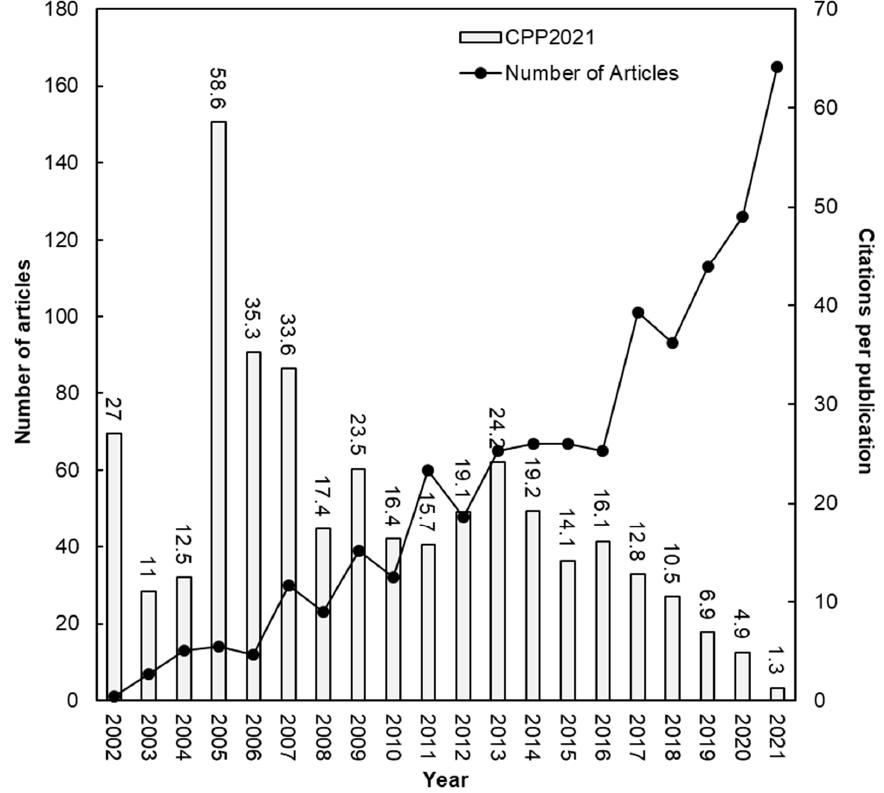
Figure 1. Number of articles and citations per publication by year.